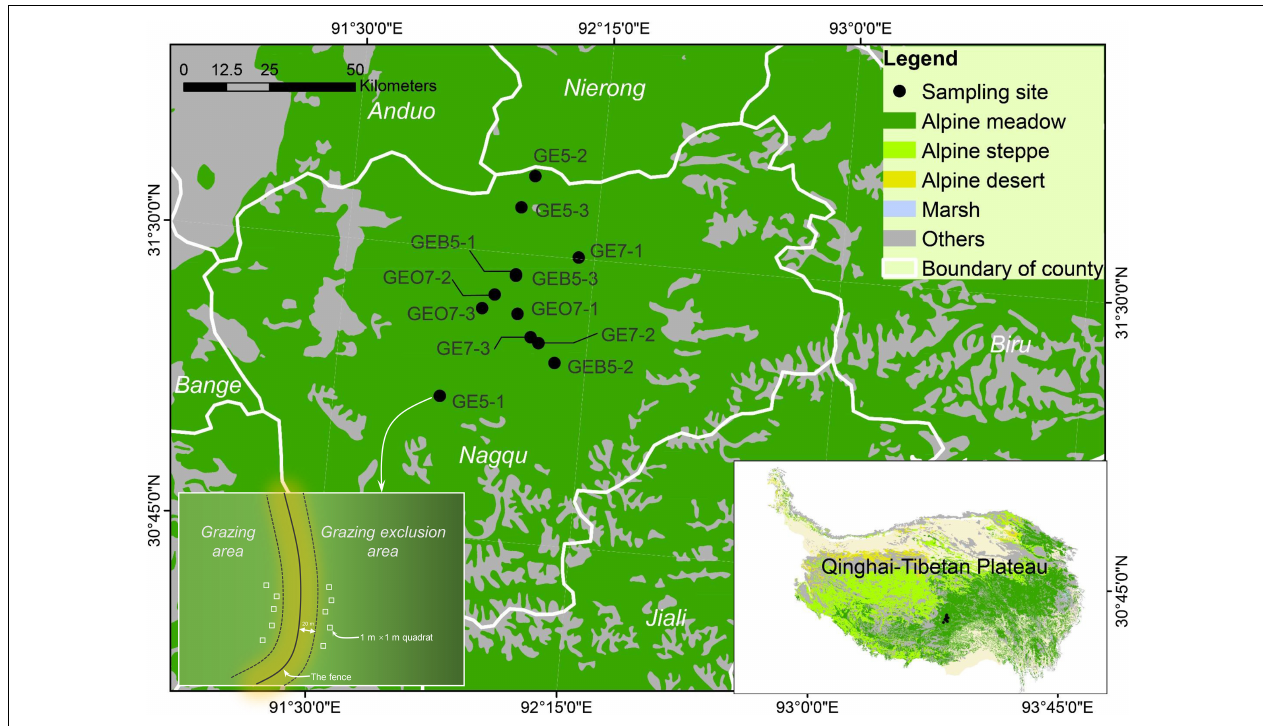
FIGURE 1 | Location of the study area. GEO7, GE7, GE5, and GEB5 represent grazing exclusion over 7 years, 7 years, 5 years, and below 5 years, respectively.